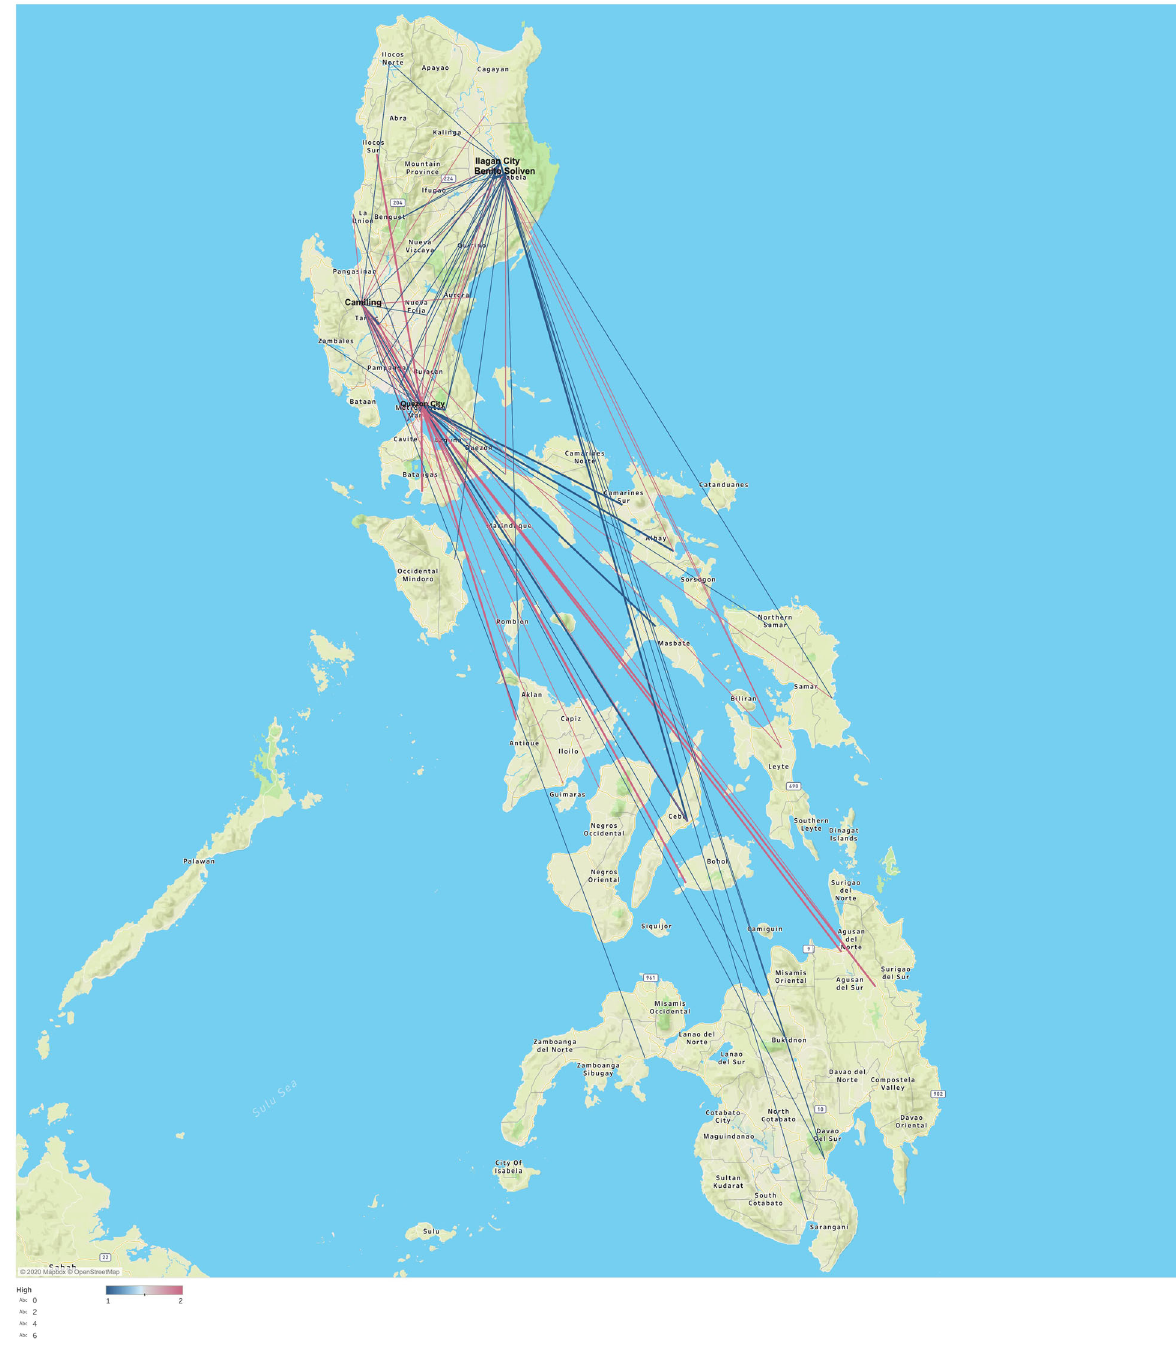
Fig. 5 Overview of internal migration movements from Luzon. Internal migration fl ows generated from the study sites in Luzon (blue lines indicate male movements and red lines female